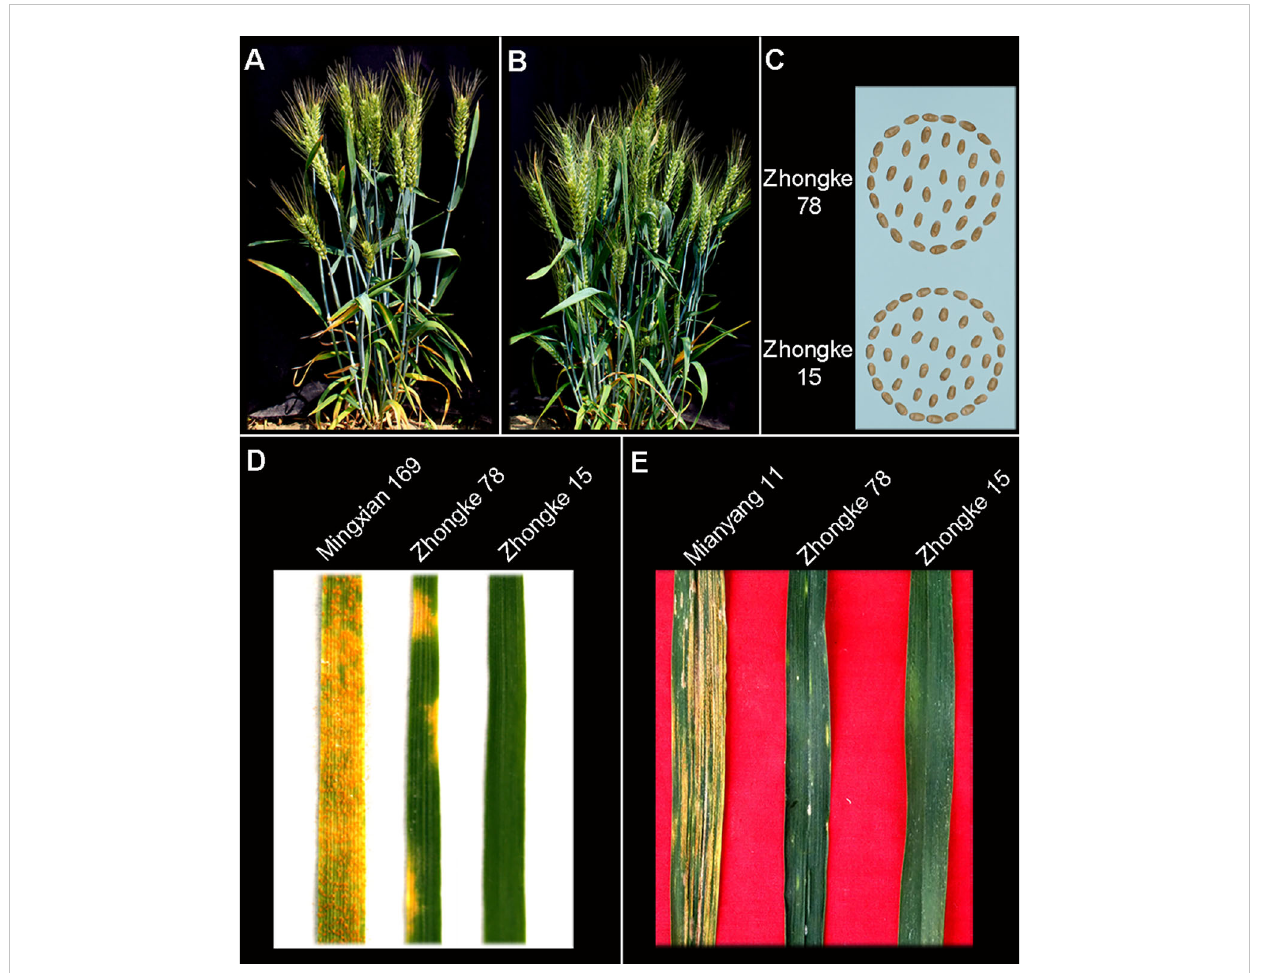
FIGURE 4 The integrated agronomic traits and stripe rust resistance of homozygous translocation lines Zhongke 78 and Zhongke 15. Phenotype of Zhongke 78 (A) and Zhongke 15 (B) . (C) Seeds of Zhongke 78 and Zhongke 15 harvested in the fi eld. (D) Stripe rust resistance evaluation of Zhongke 78 and Zhongke 15 at the seedling stage in a greenhouse by mixed races CYR32 and CYR34. (E) Stripe rust resistance evaluation of Zhongke 78 and Zhongke 15 at the adult plant in the fi eld of Chengdu, Sichuan